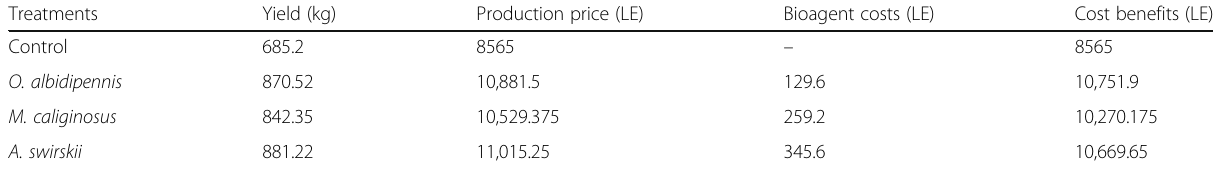
Table 2 Total production yield, bioagent costs, and cost benefits of sweet pepper when releasing the three predators, O. albidipennis , M. caliginosus , and A. swirskii , in the experimental tunnels during winter plantation of 2015 – 2016